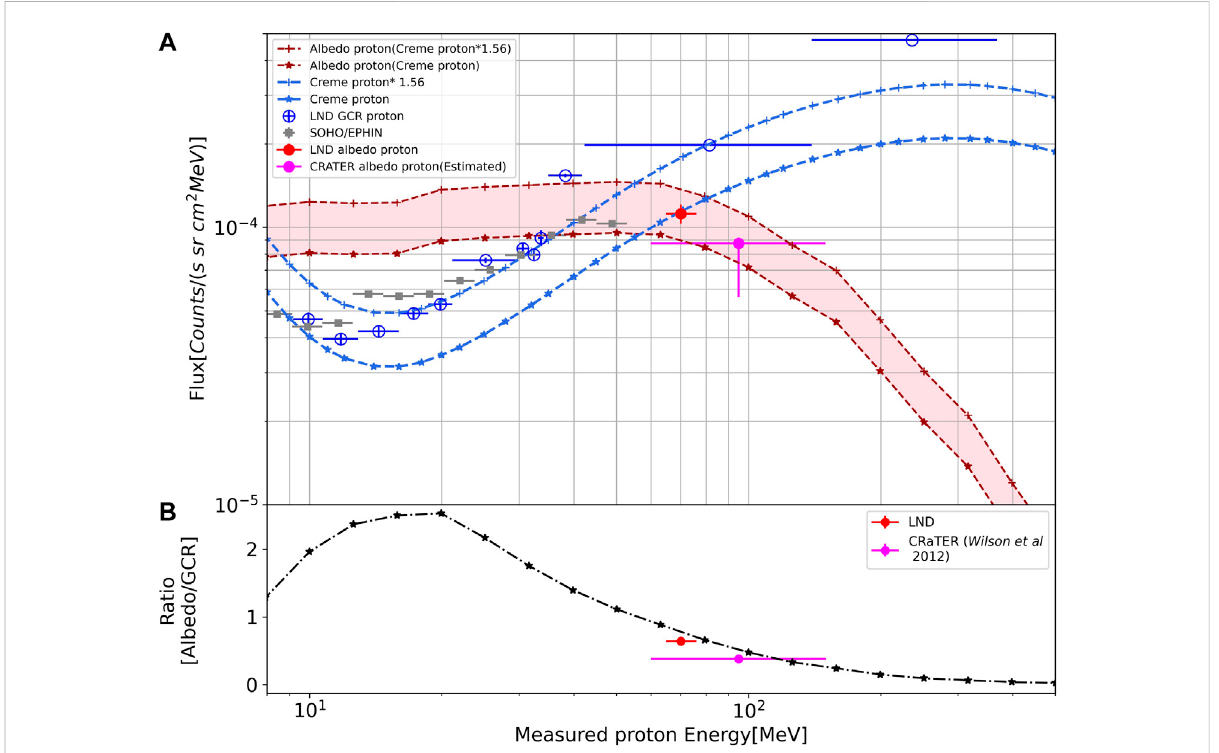
FIGURE 5 (A) TheGCRprimaryprotonspectraincludingbothmeasurements(LNDinemptybluecircles,andSOHO/EPHINingreytriangles)andmodeled results (blue dashed lines). Albedo proton spectra are drawn in reddish colors. The simulation results from REDMoon are within the transparent red area. The LND measurement of albedo protons is the red circle. The error bar is the systematic uncertainty as de fi ned in Section 2.4. The estimated albedoproton fl uxthatwederivedusingtheratioofalbedotoprimaryprotonmeasuredbyLRO/CRaTERisthemagentadatapoint. (B) Theratio of albedo to primary fl ux versus proton energy. The red and magenta points are the ratio of albedo to primary proton fl ux derived from LND data in this study and that from LRO/CRaTER data (Wilson et al., 2012), respectively. The black line shows the prediction from the REDMoon model. The detailed explanations are given in the main text, the values for the LND data points are given in Tab. S3 of supplementary